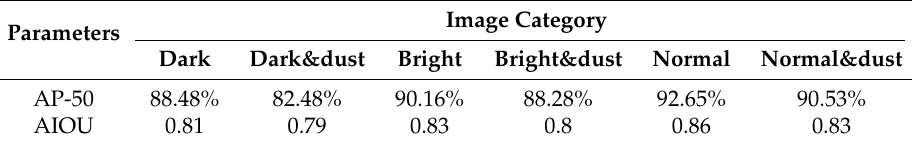
Table 1. Test results of YOLO-MobileNet.